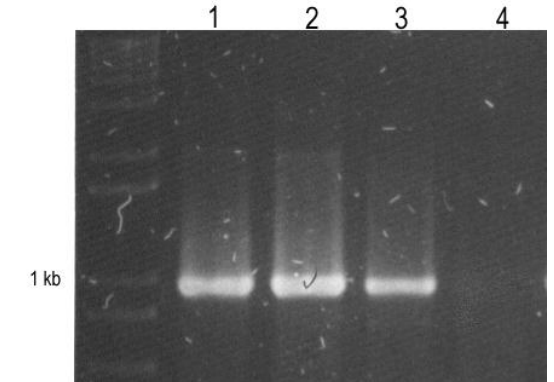
Figure 3. RT-PCR detection of Cowpea mild mottle virus (CPMMV) in infected